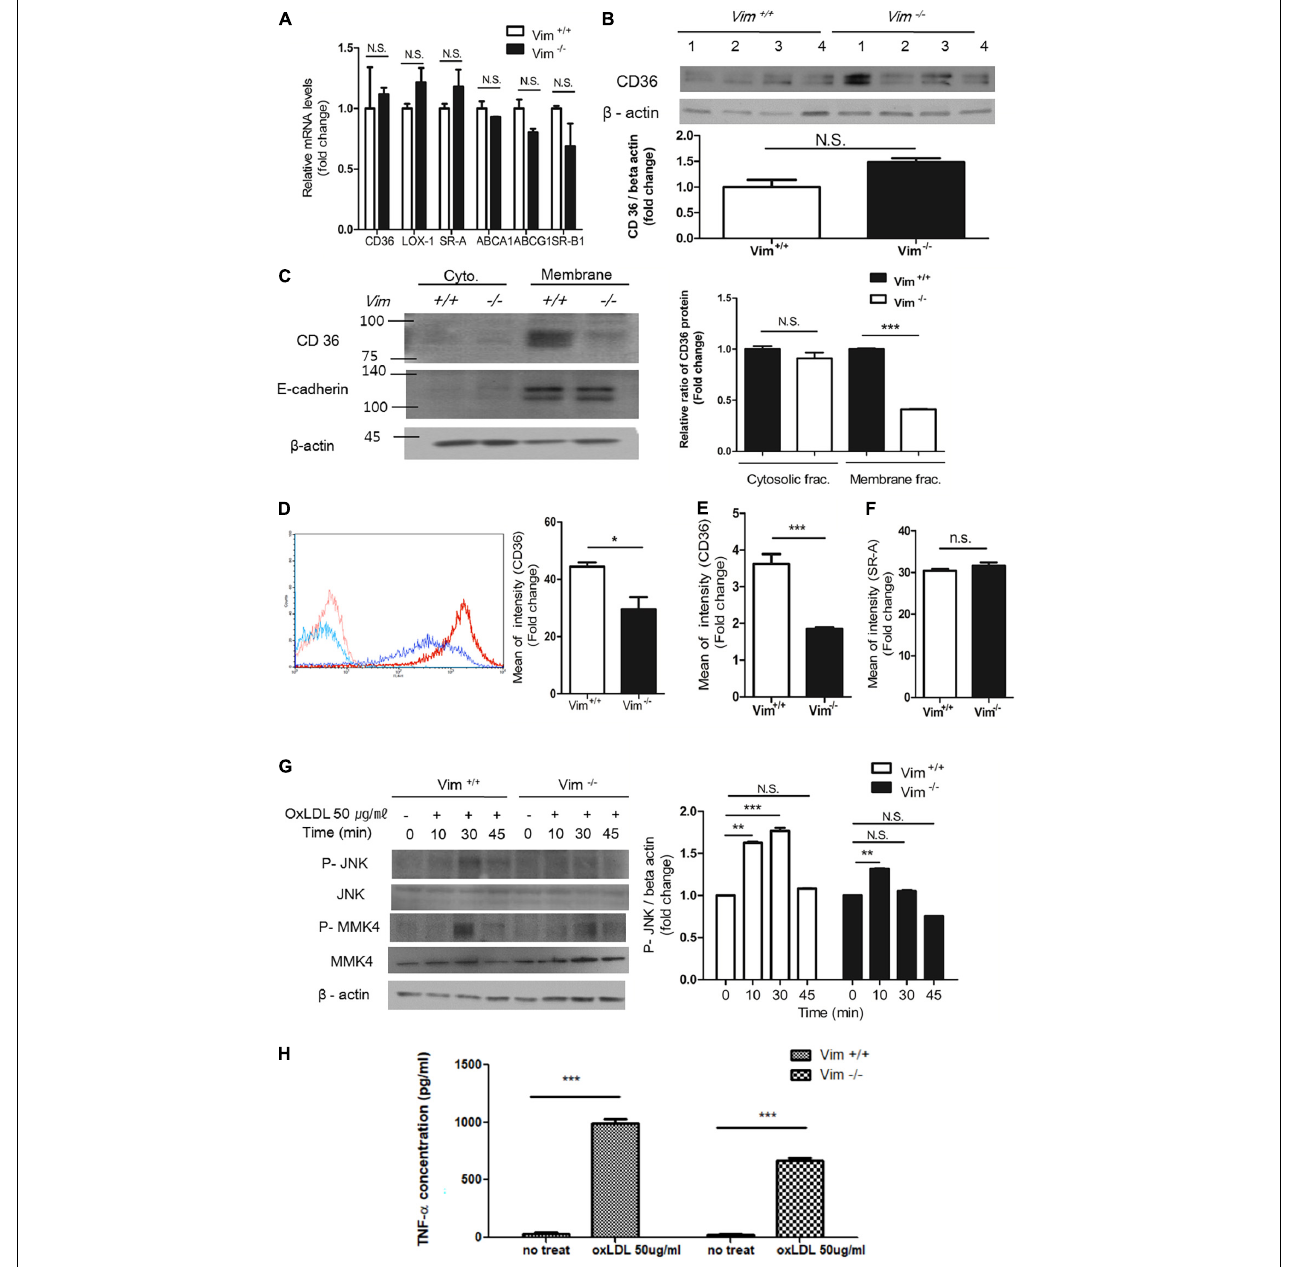
FIGURE 2 | Plasma membrane CD36 in Vim − / − macrophages was less than in Vim + / + macrophages. (A) Quantitative real-time PCR was performed with RNAs from Vim + / + and Vim − / − murine peritoneal macrophages. GAPDH was used as the internal control. (B) Western blot analysis for CD36 was performed using lysates of Vim + / + ( n = 4) and Vim − / − ( n = 4) murine peritoneal macrophages. Each lysates were harvested from different mice. Beta actin was used as the internal control. (C) Western blot analysis for CD36 was performed using fractionated lysates of Vim + / + and Vim − / − murine peritoneal macrophages. E-cadherin was used as the marker for plasma membrane fraction and GAPDH was used as the marker for cytosolic fraction. (D) Left, The representative flow cytometry data of Vim + / + murine peritoneal macrophages and Vim − / − murine peritoneal macrophages with APC conjugated monoclonal antibody specific for CD36. Both cell types were incubated with either IgG control ( Vim + / + : pink, Vim − / − : light blue) or with CD36 antibody ( Vim + / + : red, Vim − / − : dark blue). Right, Comparison of fluorescence intensities representing cell surface-localized CD36 between Vim + / + and Vim − / − murine peritoneal macrophages. (E) Flow cytometry. Comparison of fluorescence intensities representing cell surface-localized CD36 between Vim + / + and Vim − / − murine bone marrow-derived macrophages (BMDM). (F) Flow cytometry. Comparison of fluorescence intensities representing cell surface-localized SR-A between Vim + / + and Vim − / − murine peritoneal macrophages. (G) Western blot analysis for phospho-JNK, phospho-MMK4 and beta actin using lysates of Vim + / + and Vim − / − murine peritoneal macrophages. Cells were incubated with oxLDL (50 µ g/ml) for indicated times. Beta actin was used as the internal control. * p < 0.05, ** p < 0.01, *** p < 0.001. The graph shows mean ± SEM for triplicated determinants of the experiments. (H) Vim + / + and Vim − / − macrophages were treated with or without oxLDL (50 µ g/ml) and TNF- α released by the macrophages in the media was measured by ELISA. *** p <